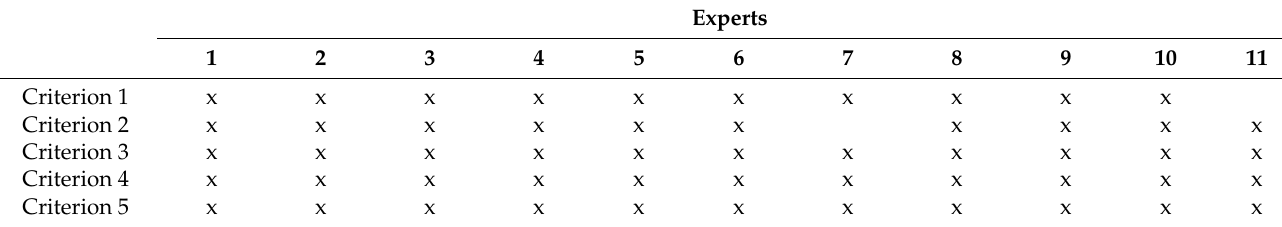
Table 1. Inclusion criteria met by